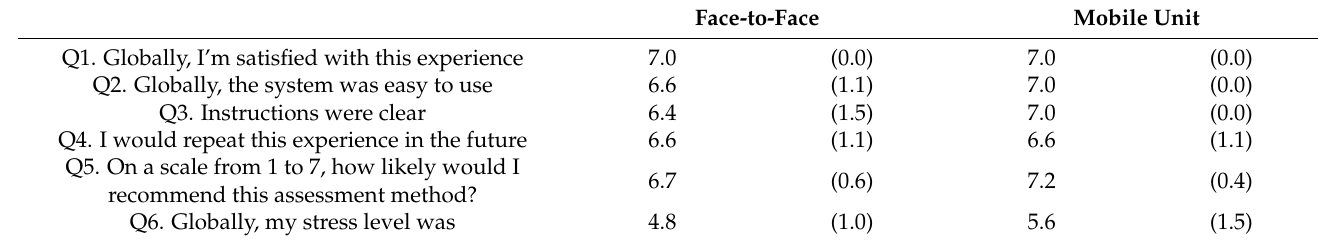
Table 4. Acceptability survey. Questions were rated from 1 “I completely disagree” to 7 “I completely agree”. N = 8. Mean (SD).